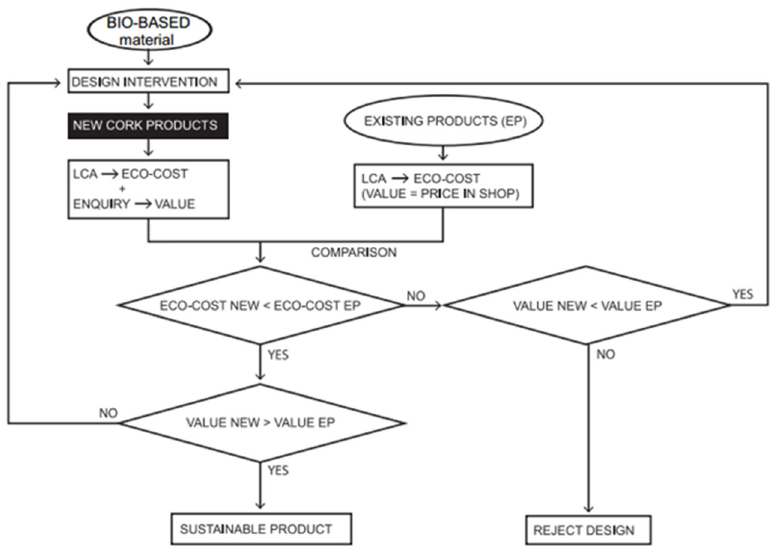
Figure 7. The basics of eco-efficient value creation in the fuzzy front end of the design [13].